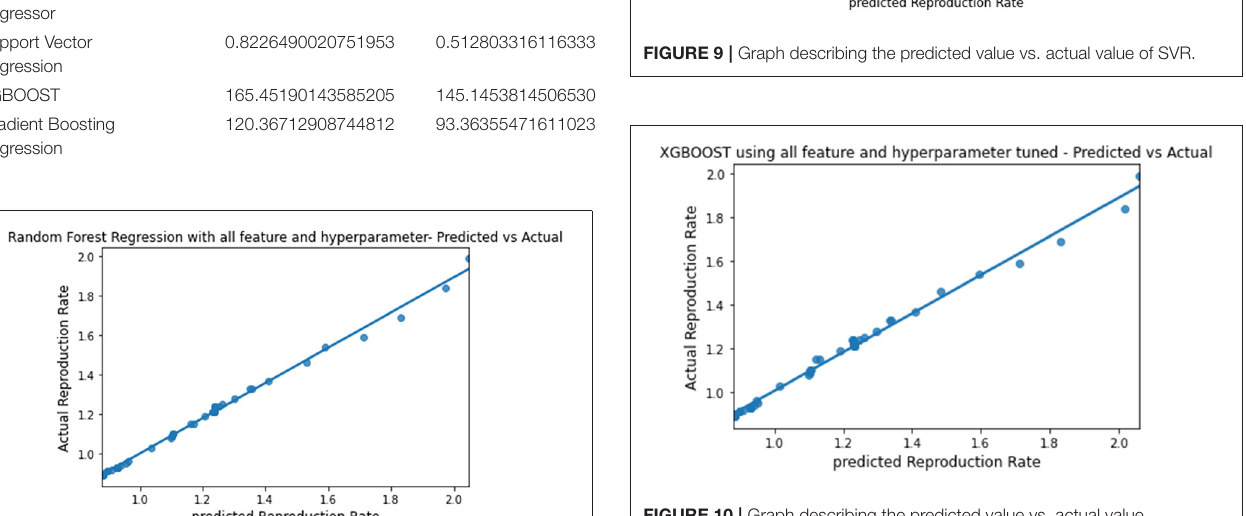
FIGURE 10 | Graph describing the predicted value vs. actual value of XGBoost.